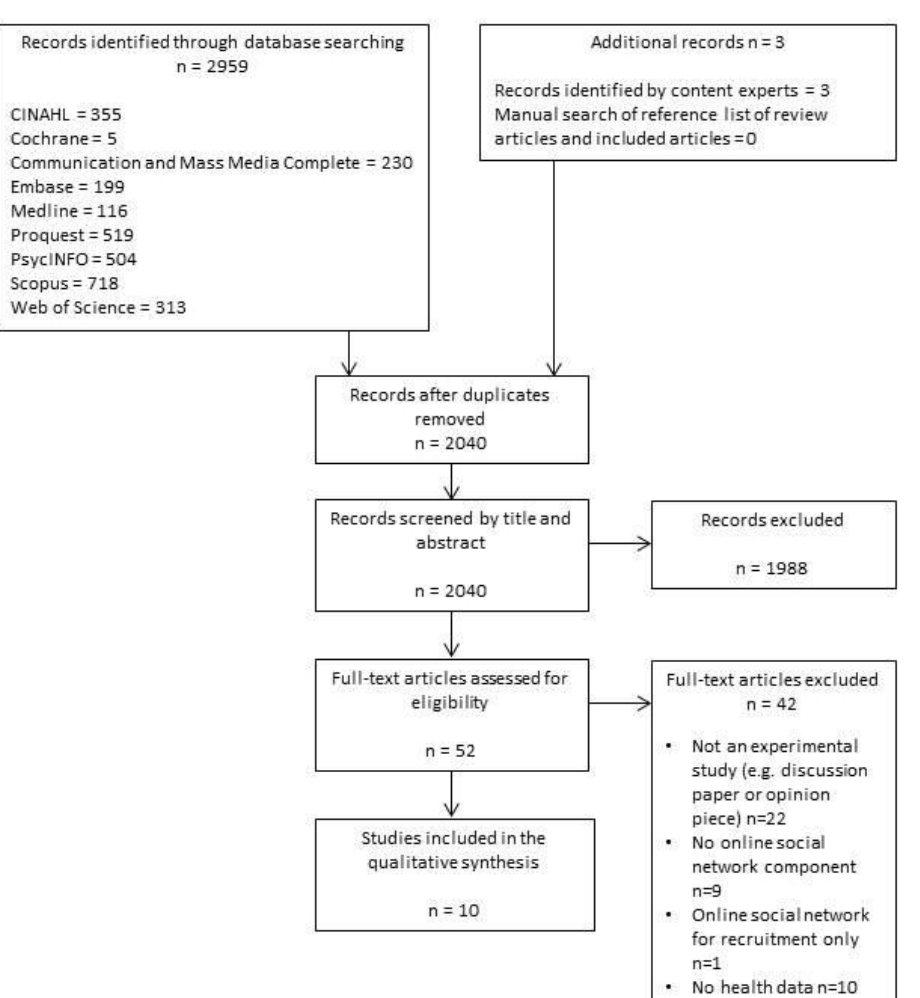
Figure 1. Flow of studies through the